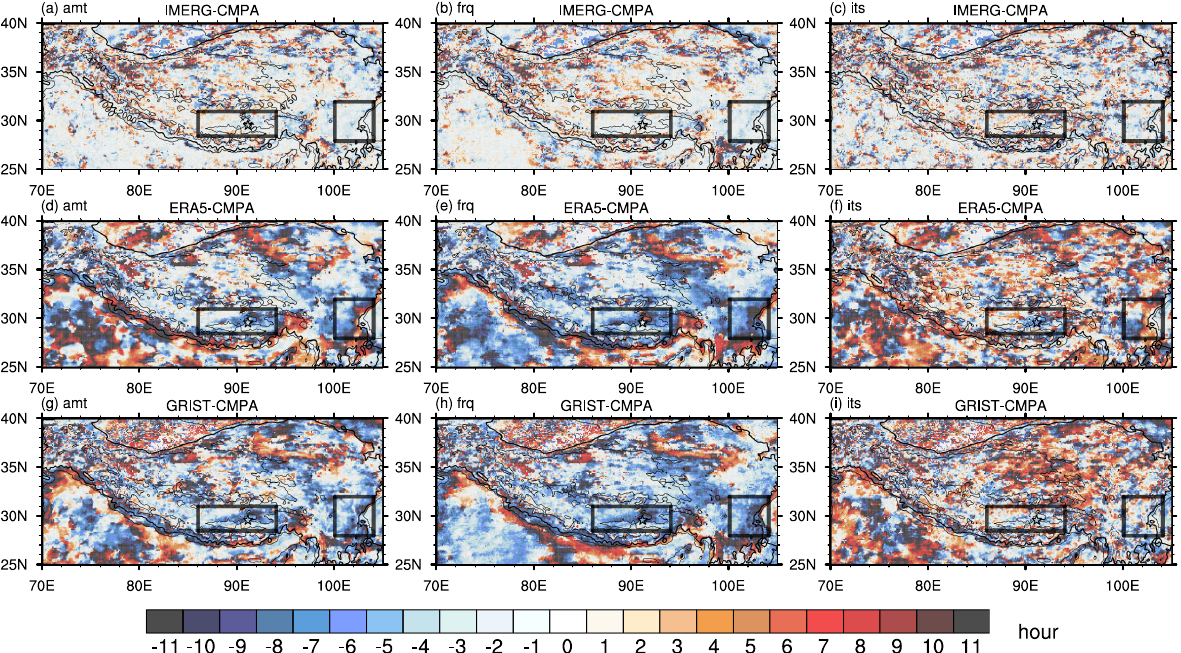
Figure 6. Spatial distribution of the diurnal phase differences (hour, left: amount; middle: frequency; right: intensity) between IMERG and CMPA ( a – c ), between ERA5 and CMPA ( d – f ), and between GRIST and CMPA ( g – i ).The pentagram indicates the location of Lhasa. The thick black contour depicts terrain heights of 2000 m, and the thin black contours represent 1000 and 4750